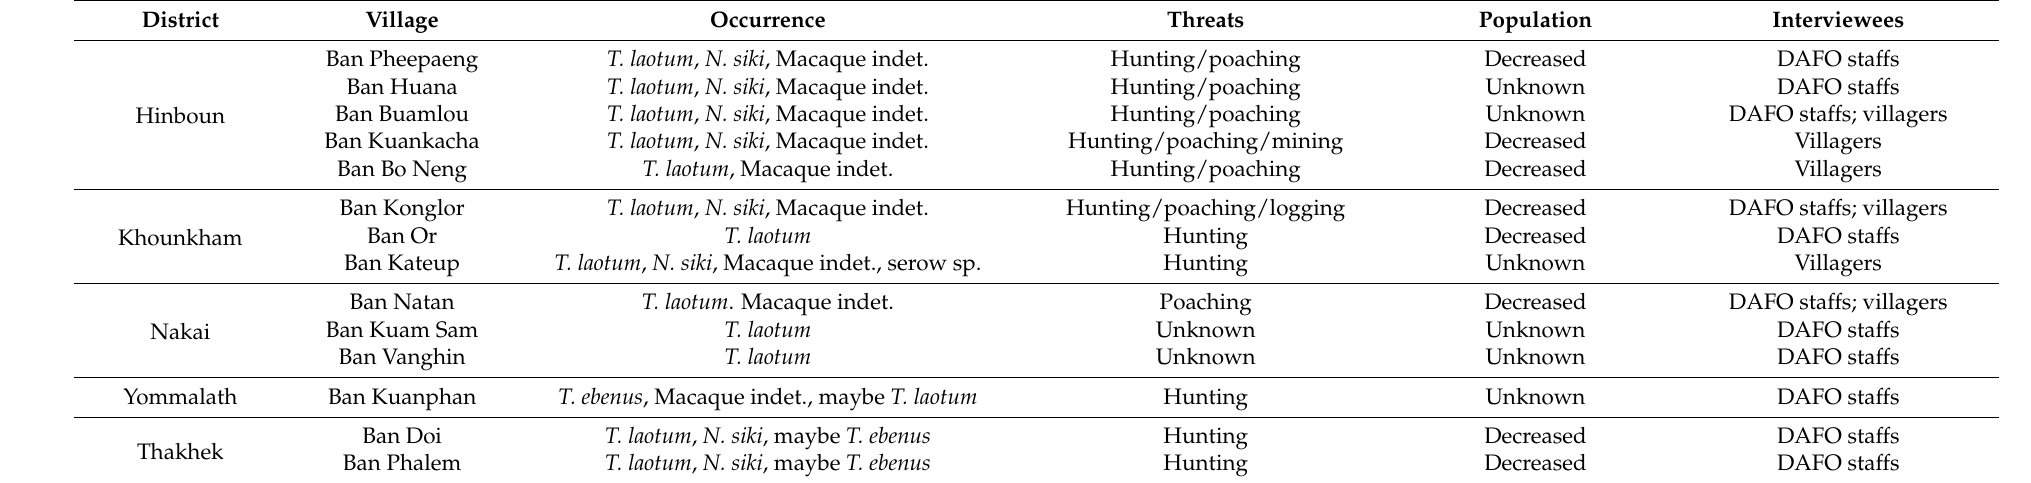
Table 1. Species occurrence and threats as emerged from interview results. For more details, see the